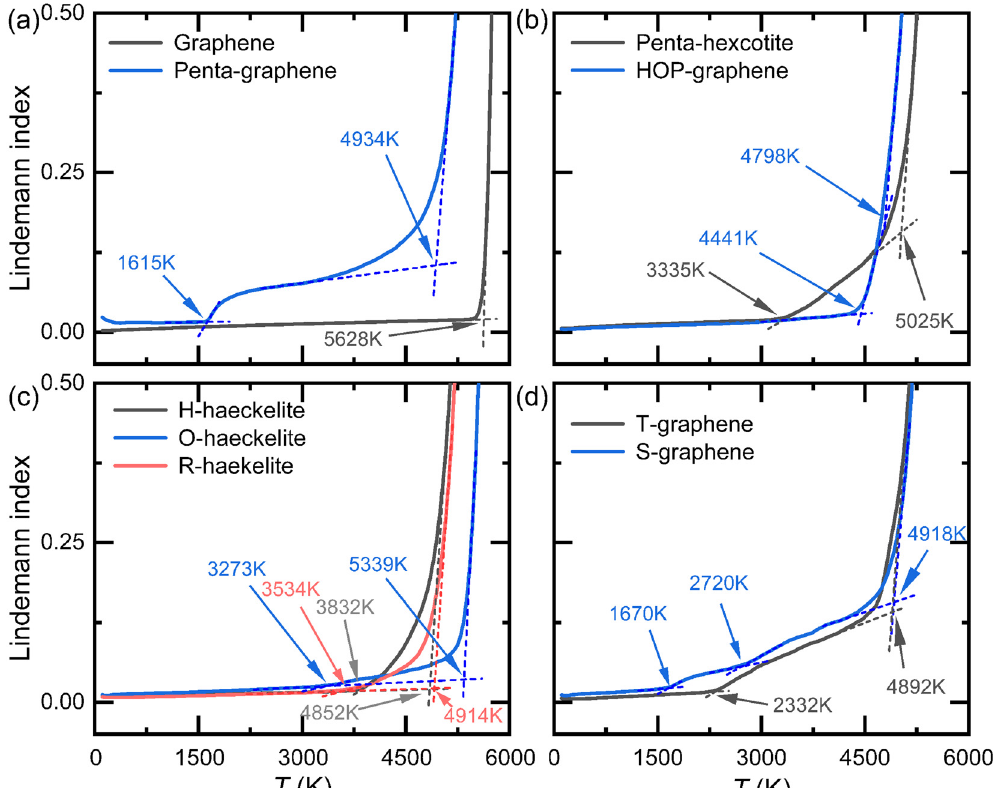
Figure 3: Temperature dependence of average LI for ( a ) graphene and penta - graphene; ( b ) penta - hexoctite and HOP - graphene; ( c ) H - , O - , and R - haeckelites; and ( d ) T - and S - graphene,